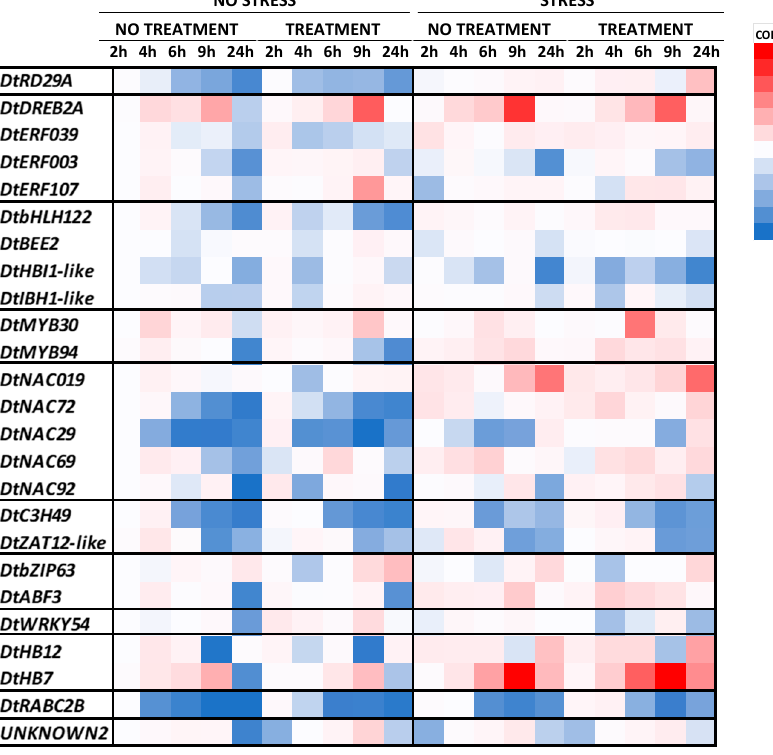
Figure 1. Heatmap showing temporal expression (2 − ∆∆ Ct ) of selected transcription factors associated with salt stress responses in rocket plants grown under salt stress condition and treated with a borage extract. The rows represent the transcription factors and within each row, the blue shaded areas indicate downregulated gene expression, whereas the red shaded areas indicate upregulated gene expression.